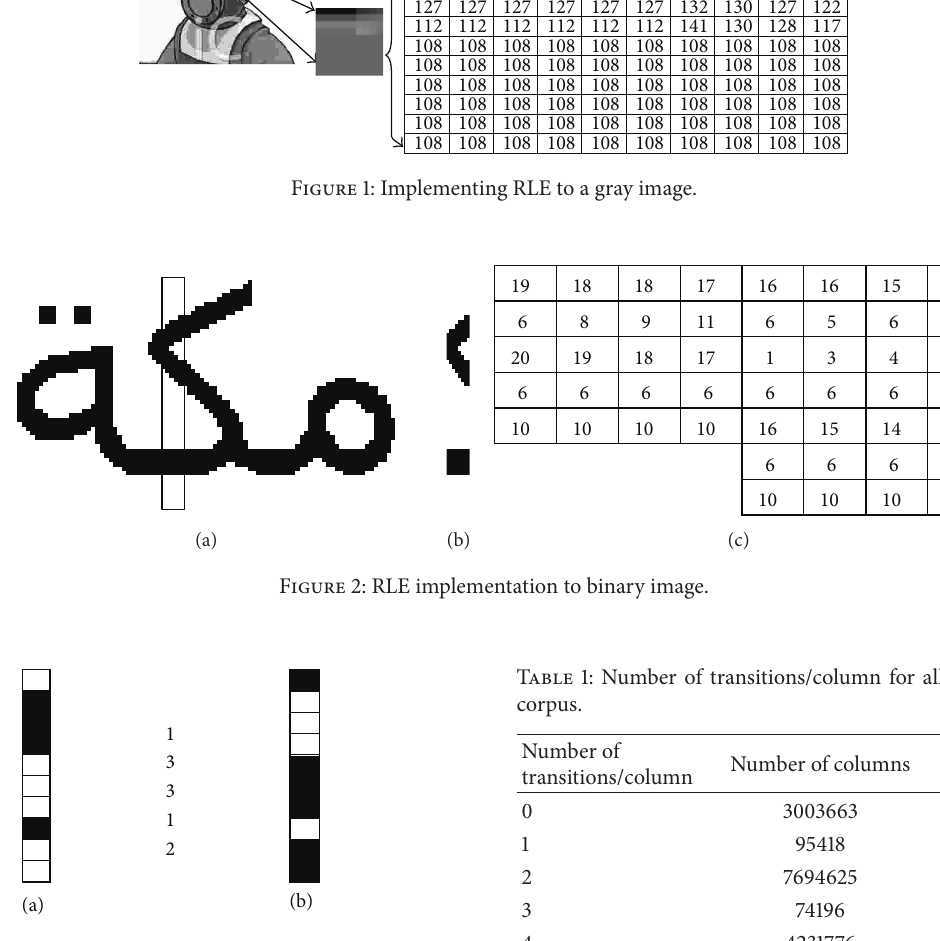
Figure 3: Encoding individual columns.